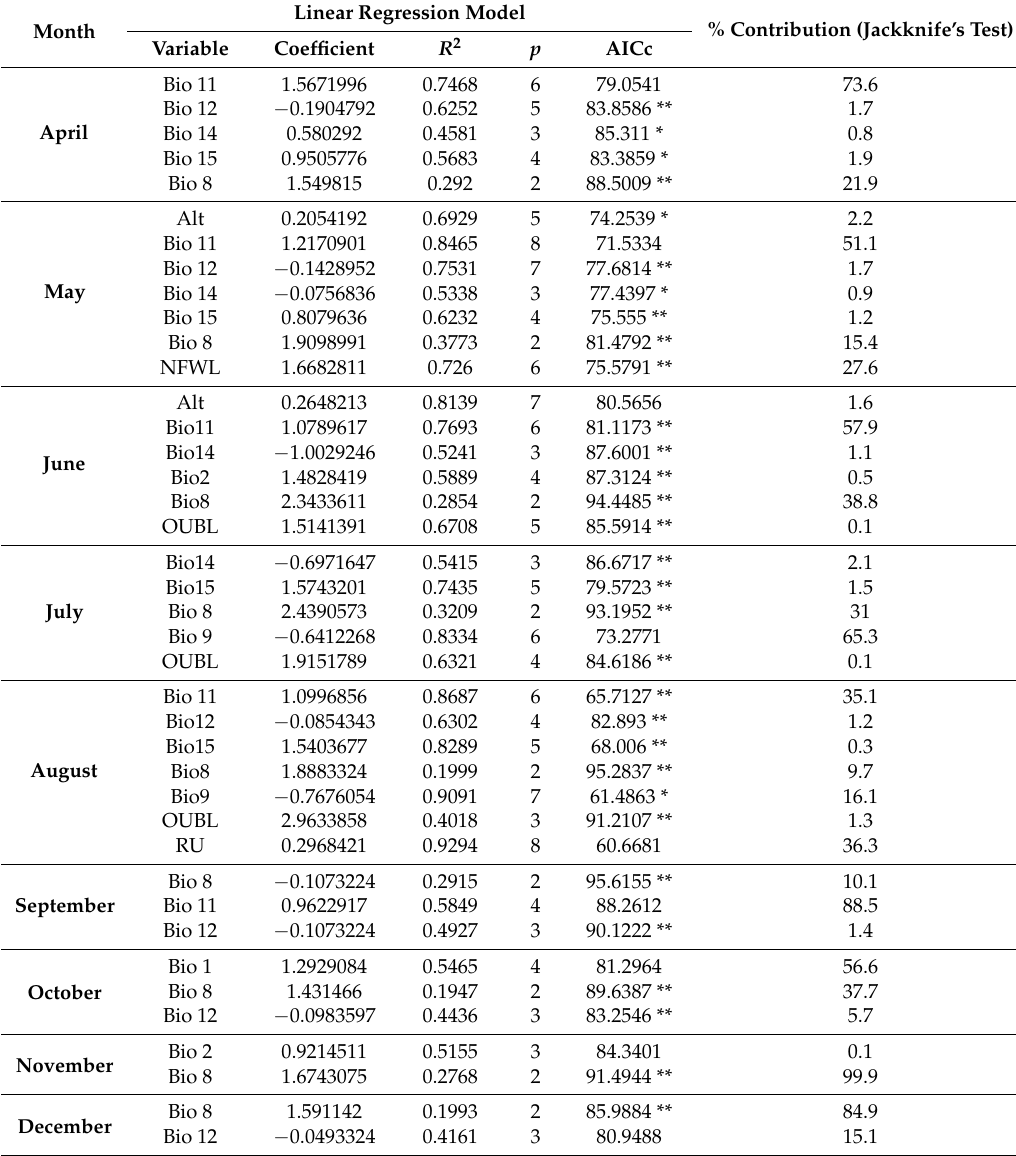
Table 5. Percent contribution of predicting variables on temporal distribution of vector-host contact ratios of WNV in the City of New Orleans,